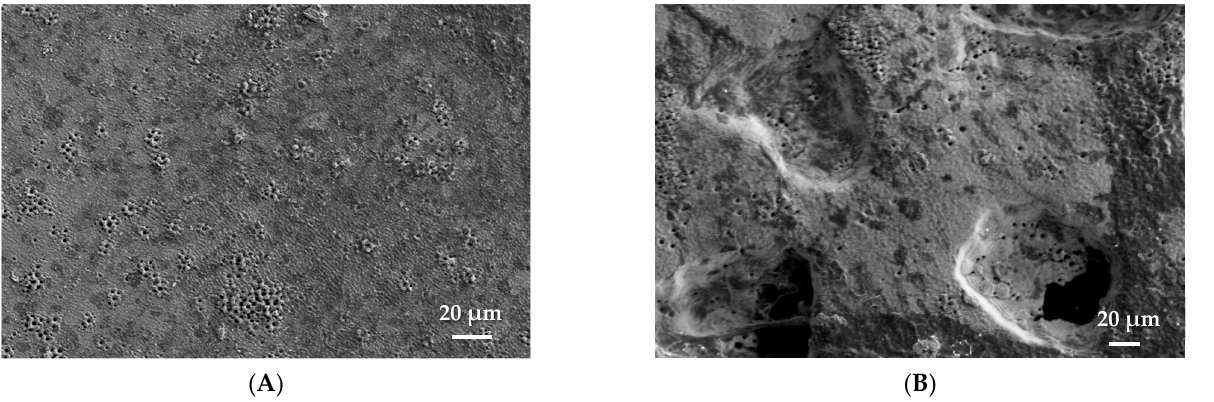
Figure 6. SEM Image of a samples of porous titanium after the femtosecond surface treatment in-vitro culture (observe the presence of adhered osteoblasts). ( A ) Fully-dense; ( B ) 30 vol. % (100–200 µm).